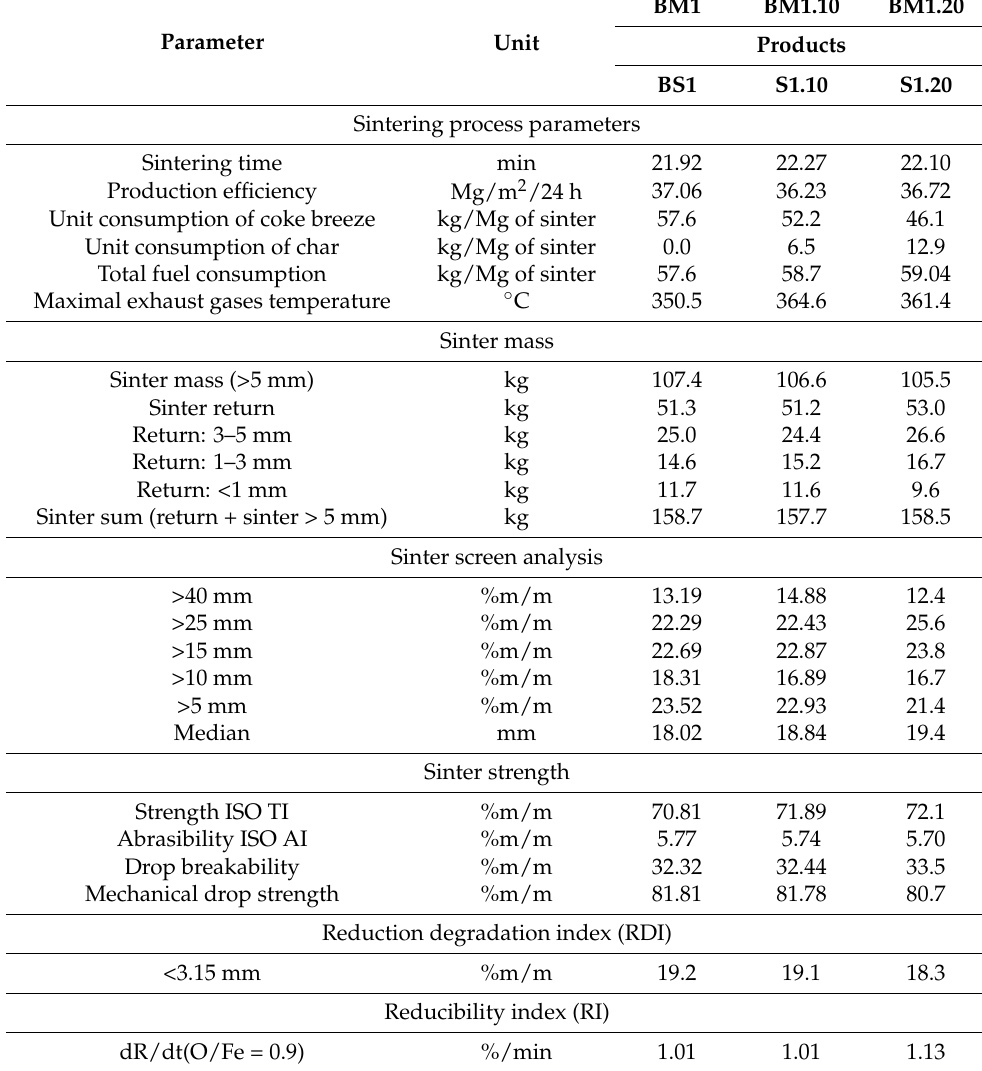
Table 5. Technological parameters of the sintering process for BM1, BM1.10, and BM1.20 and sinter quality.